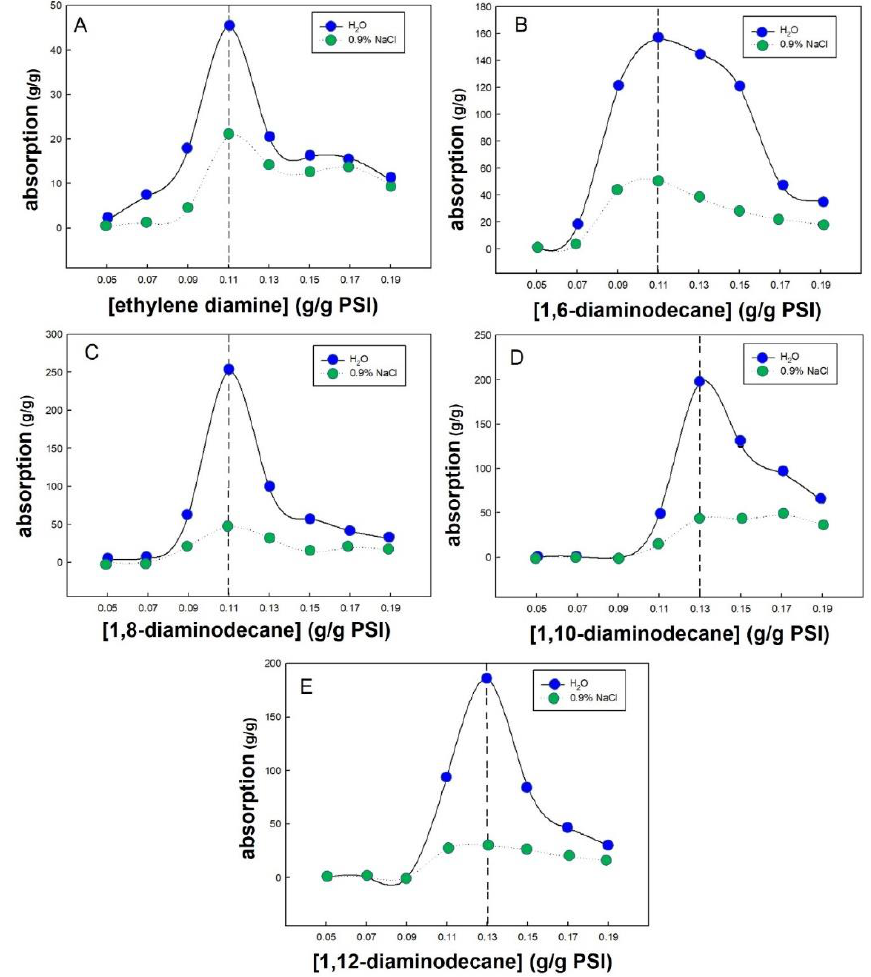
Figure 5. The effect of the concentration of the cross-linking agent: ( A ) ethylene diamine, ( B ) 1,6- diaminodecane, ( C ) 1,8-diaminodecane, ( D ) 1,10-diaminodecane, ( E ) 1,12-diaminododecane, on the water and saltwater absorption.